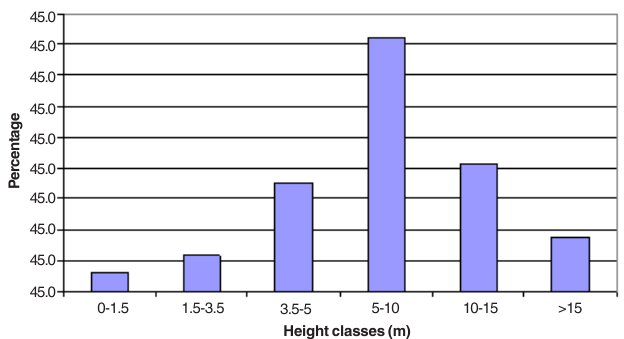
Figure 2. Vertical distribution of L.t. tardigradus